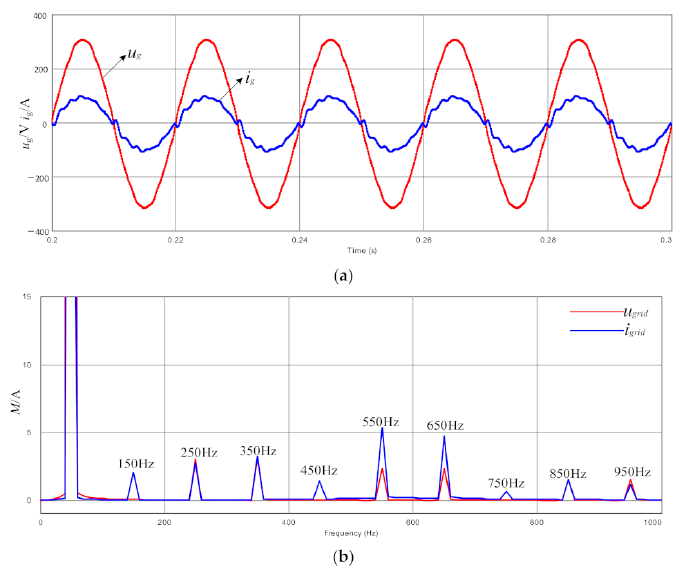
Figure 17. Waveforms of grid voltage and grid-tie current under the distorted power grid (without using combined harmonic suppression): ( a ) Time domain waveform of grid voltage and grid-tie current; ( b ) Spectrum of grid voltage and grid-tie